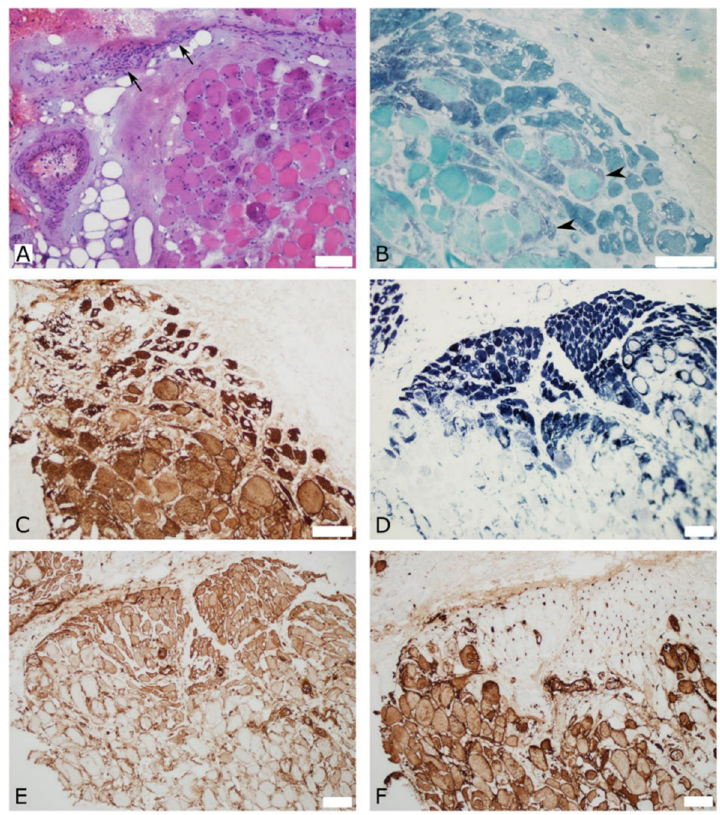
Figure 2. Quadriceps muscle biopsy with perifascicular findings that are suggestive of myositis. ( A ) Hematoxylin and eosin stain shows perivascular mononuclear cellularity (arrows) in the perimysium, and perimysial and endomysial fibrosis. ( B ) Gomori trichome stain shows perifascicular atrophic fibers and small vacuoles, as well as signs of regeneration (arrowheads). ( C ) Slow myosin immunostaining highlights perifascicular atrophy and small vacuoles. ( D ) Dense staining with reduced nicotinamide adenine dinucleotide (NADH) dehydrogenase in perifascicular atrophic fibers, and no staining of necrotic fibers. ( E ) Major histocompatibility complex class I (MHC-I) is up-regulated in perifascicular myofibers. ( F ) Membranolytic attack complex (C5b-9) immunostaining shows significant capillary deposition in the perifascicular region and highlights necrotic fibers. Scale bars = 100 μ m.